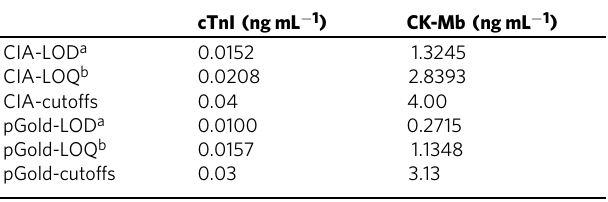
Table 1 LODs, LOQs, and cutoffs using pGold chip and